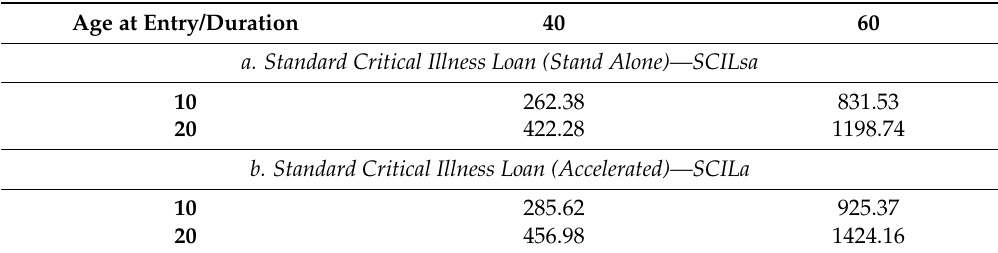
Table 2. Actuarial periodic premium—female non-smokers. Issue time 2014, r = 2%, i = 7%, C = 200,000.